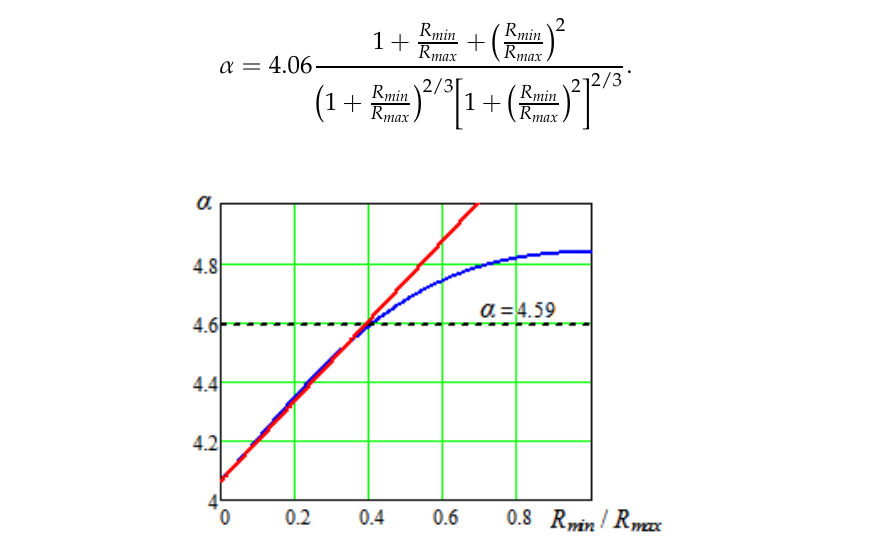
Figure 3. The dependence of the contact area ratio on the variation coefficient for the uniform distribution law. distribution